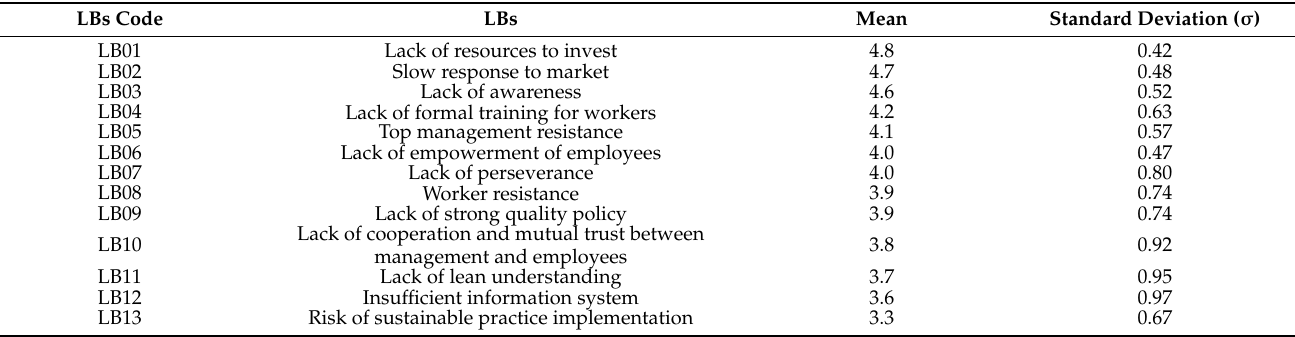
Table 2. LBs identified for the present studies.